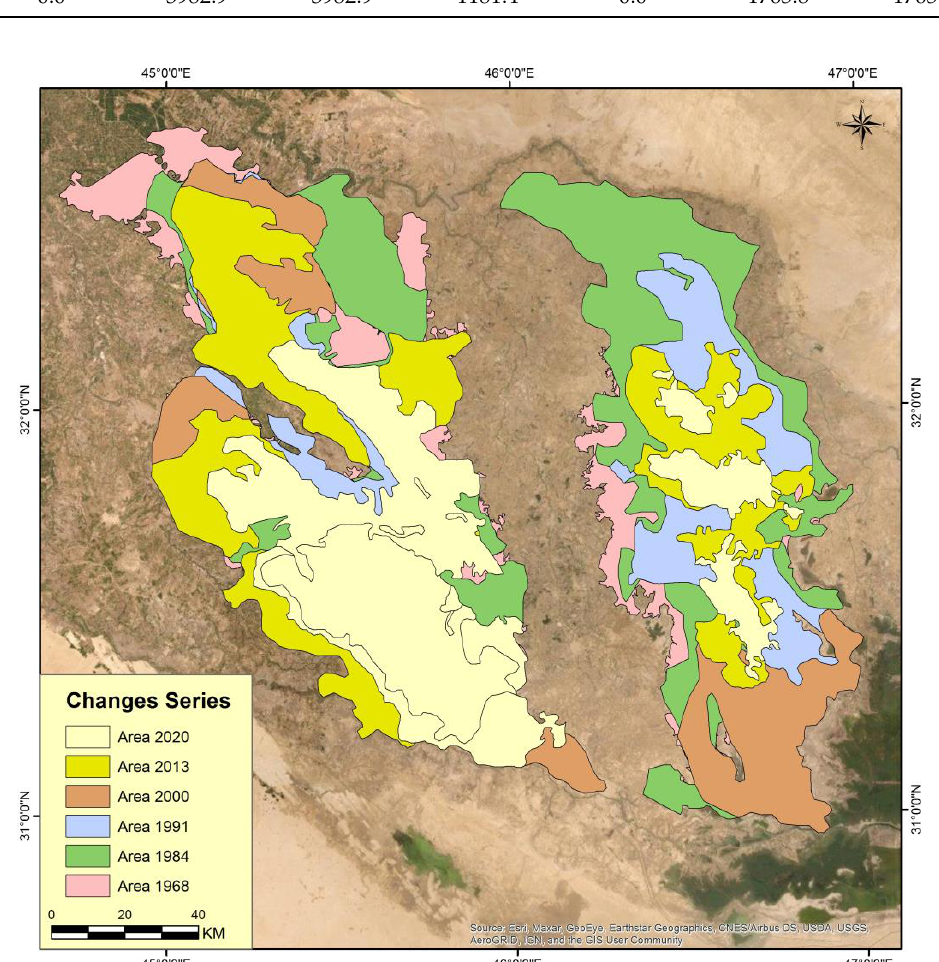
Figure 12. Changes series total area of the two SDS hotspots during 1968, 1984, 1991, 2000, 2013,